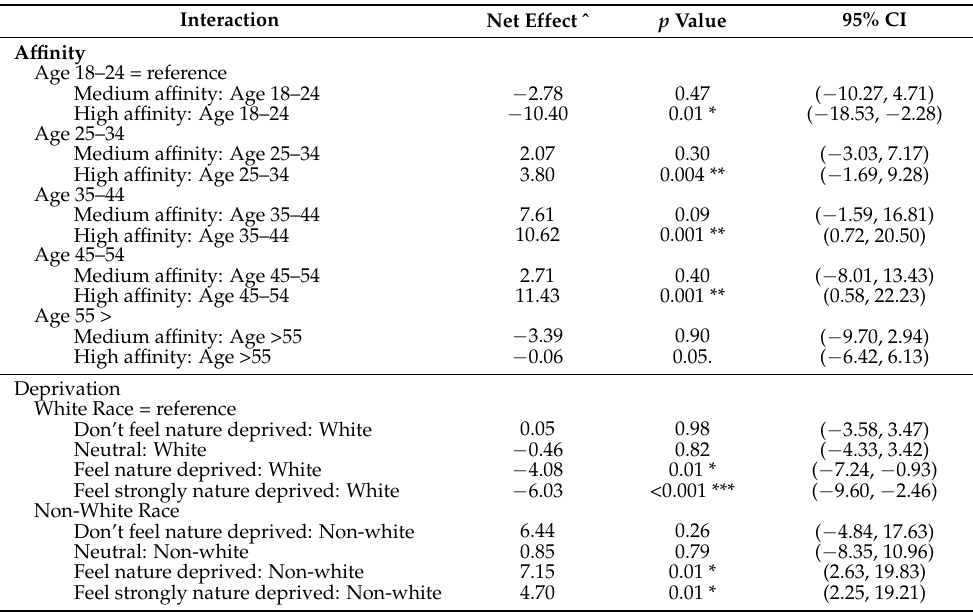
Figure 2. Interaction models of nature affinity and age (left) and nature deprivation and race (right) on flourishing. ( Left ) Stronger affinity associated with flourishing loss in ages 18–24 but gains in mid-age groups. ( Right ) Stronger perceived deprivation related to flourishing losses among whites but gains among non-whites. 4. Discussion Table 4. Interaction of nature affinity, nature deprivation with sociodemographic variables to predict